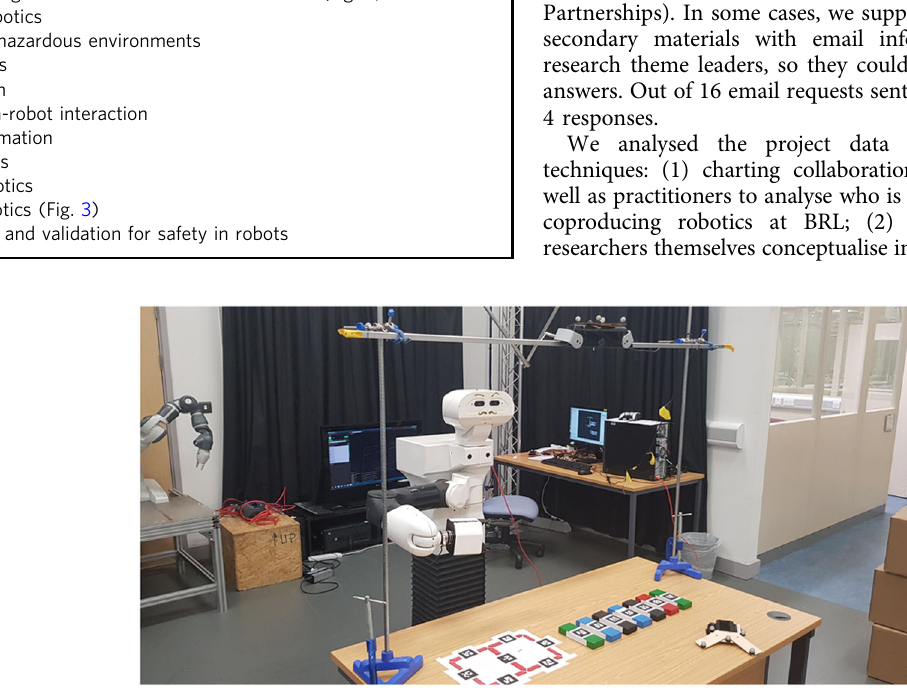
Fig. 2 An experimental setup for investigating human and robot cognitive behaviour in human-robot collaboration. Participants and robot use the blocks to create alphanumeric characters on a seven-segment using coloured blocks. (Credit: Mehdi